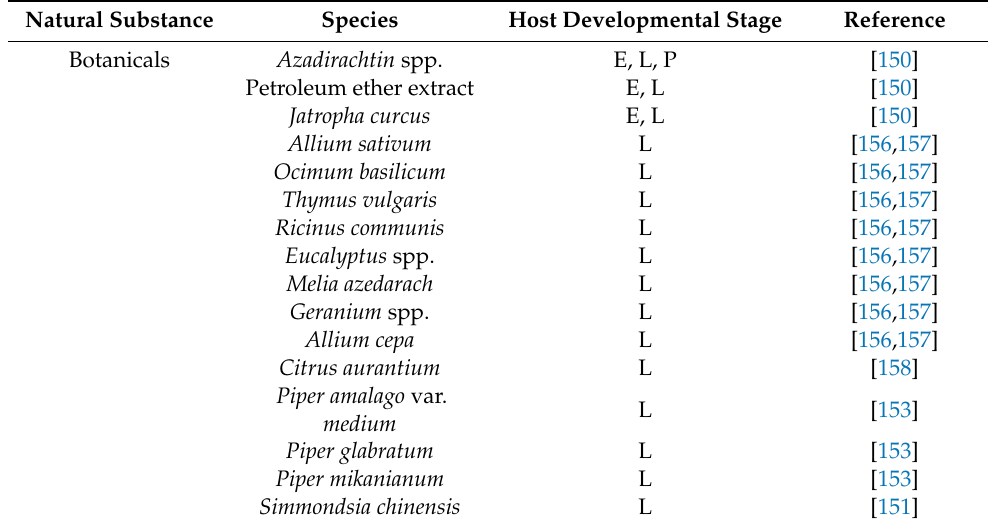
Table 2. Insecticidal plants used to make botanicals used against Tuta absoluta (Eggs—E; Larvae—L; Pupa—P; Adults—A). The records were obtained from the literature at the time of writing and may not be purely